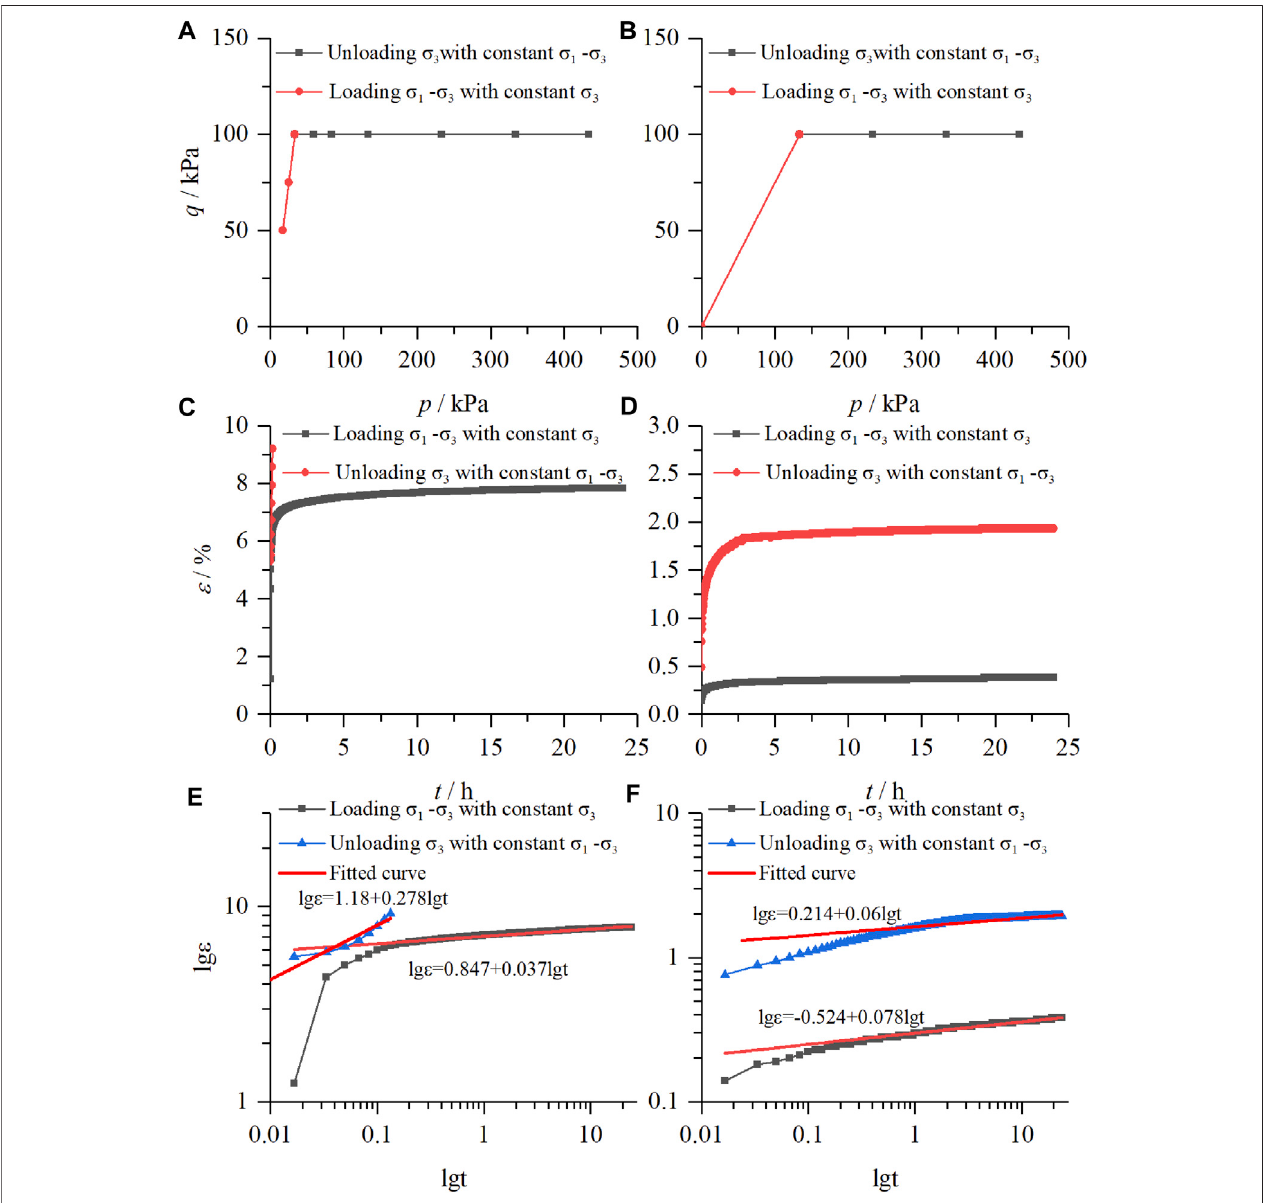
FIGURE 9| Comparison of unloading the con fi ning pressure in steps with constant deviator stress and loading the deviator stress in steps with constant con fi ning pressure, (A) (B) the relationship of mean net stress and deviator stress, (C) (D) strain-time curves, (E) (F) double logarithmic curves of strain time.